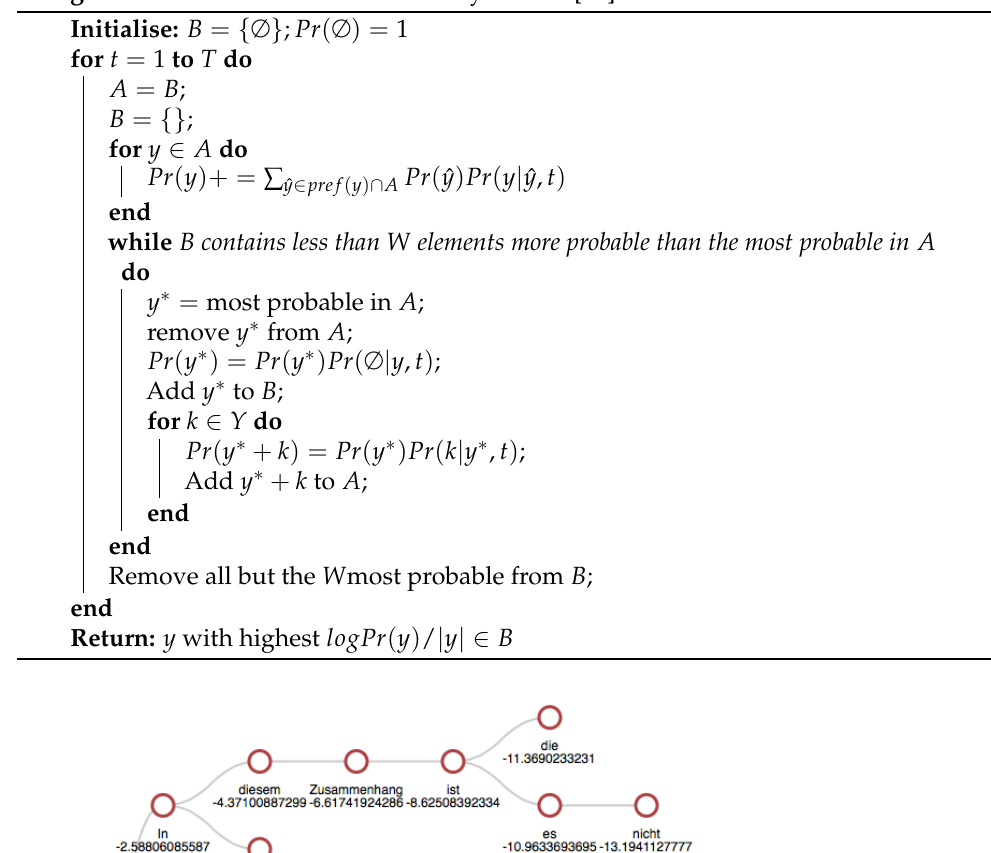
Algorithm 1: Beam search as defined by Graves [39].